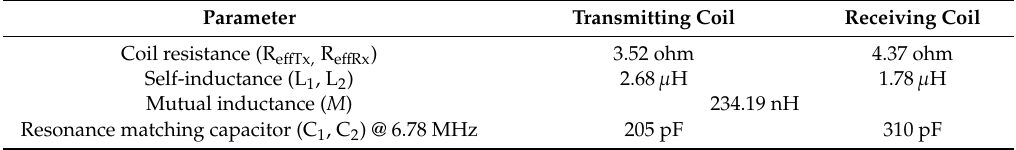
Table 4. Electrical characteristic of wireless power transfer system coils for experiment.